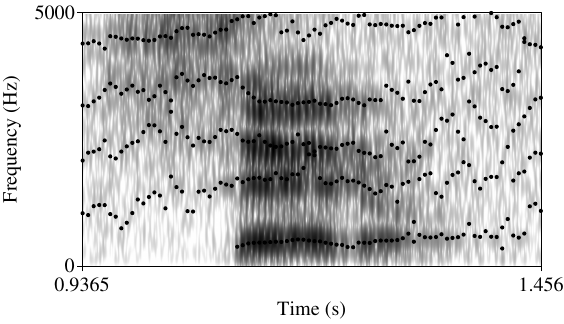
Figure 2. A spectrogram: time VS frequencies. Formants are highlighted as